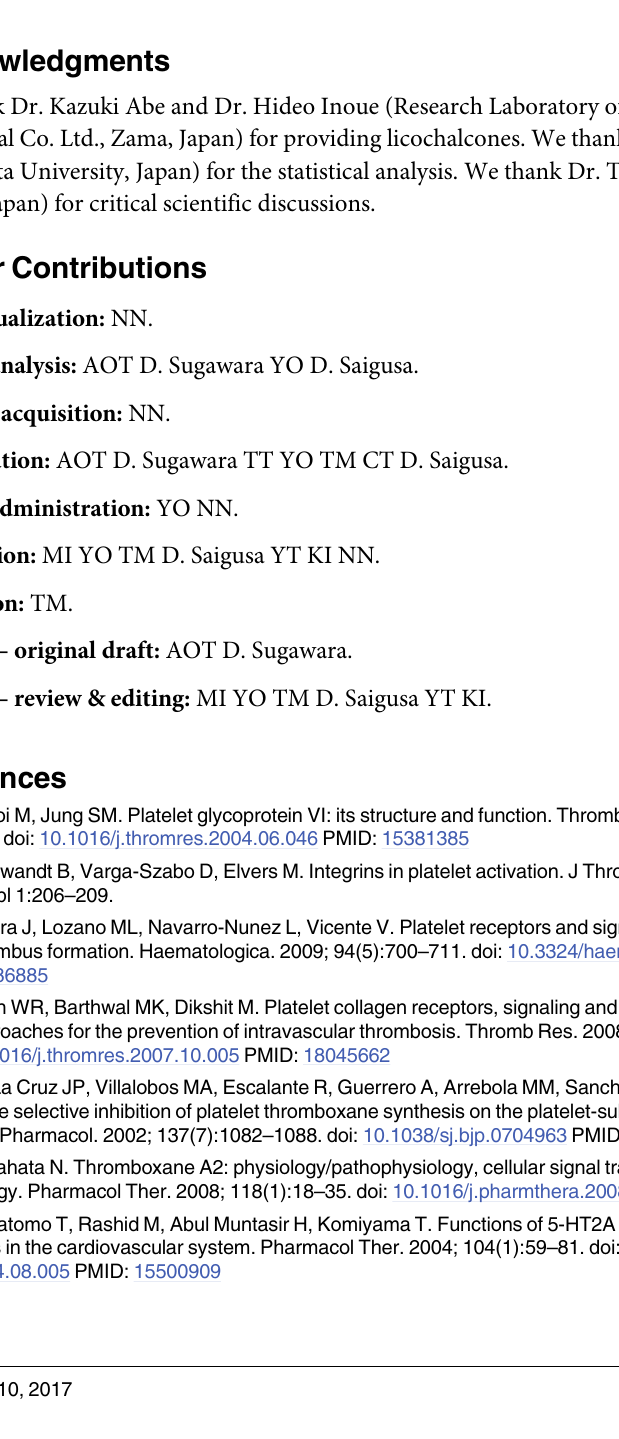
S1 Fig. Effect of licochalcone A on ADP-induced platelet aggregation. Licochalcone A (Lico. A, 10 or 100 μM) or DMSO (-) was preincubated for 5 min before addition of ADP (10 μM) in the presence of 1 mM CaCl . Results are shown as mean±S.E.M. ( (cid:3) P < 0.05 com- 2 pared with control, n = 4–7, Dunnett’s method).